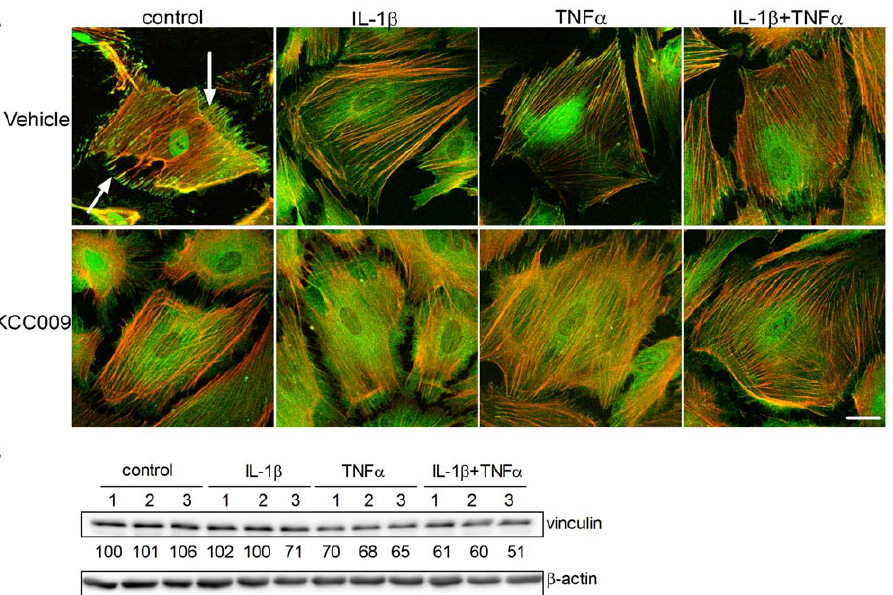
Figure 6. The effect of cytokine treatment and inhibition of TG2 activity on cytoskeletal rearrangements and RhoA activity. A ) Confocal images of cells stained with rhodamin phalloidin (red) and an antibody against vinculin (green). Scale bar: 10 m m. B ) Representative western blot of vinculin and b -Actin (n=3). Semi-quantitative analysis of vinculin levels were corrected for b -Actin and the untreated control was set at 100%. The corrected levels are shown under the vinculin-blot. Cells were cultured in medium alone or medium containing IL-1 b , TNF a or the combination for 48 h. Subsequently, cells were treated as follows: 1=untreated, 2=vehicle-treated, 3=KCC009-treated.